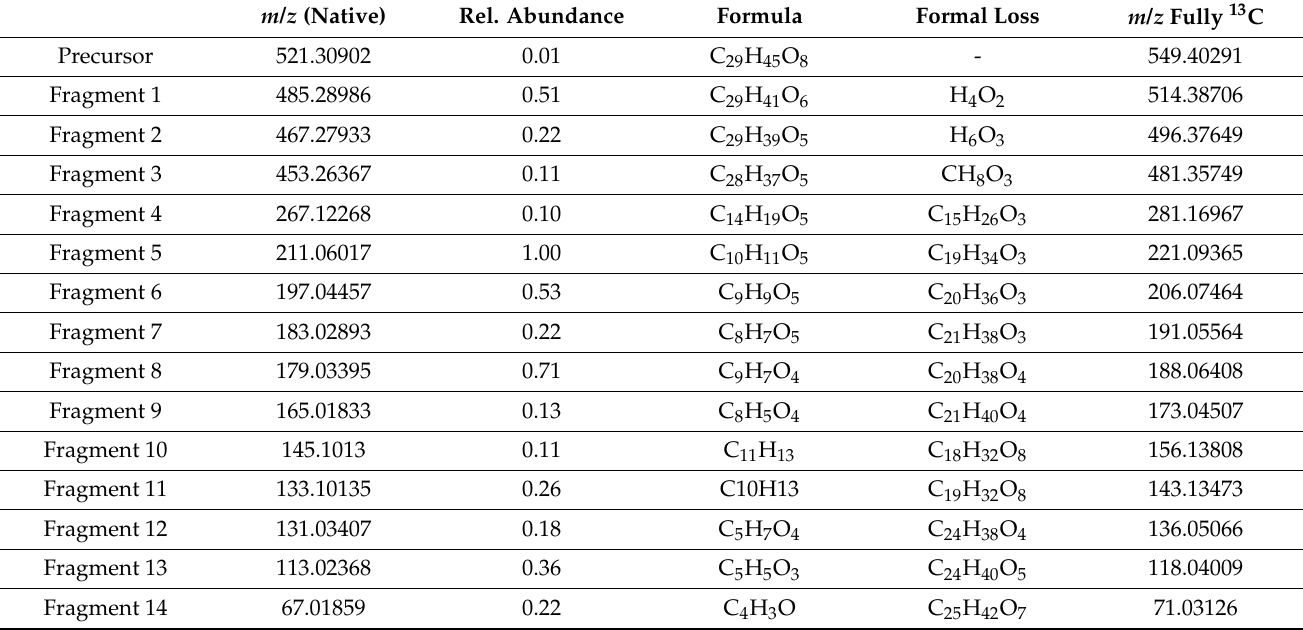
Table 2. MS/MS fragment annotations of gramiketide A spectrum. m / z (Native) Rel.